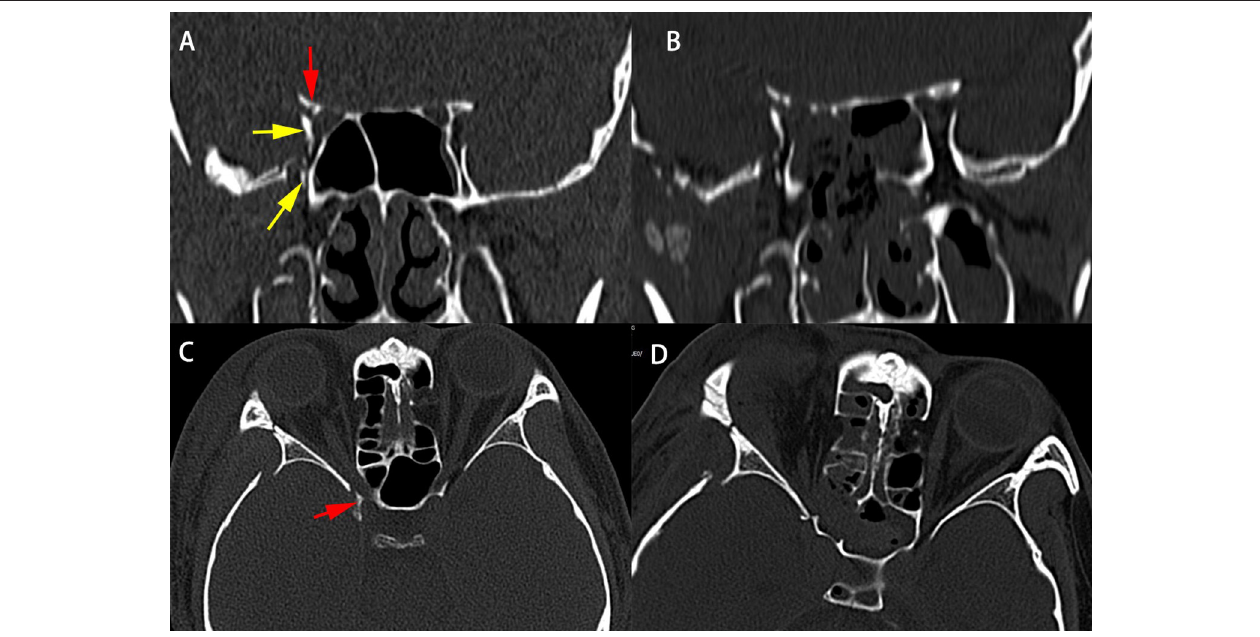
FIGURE 5 | CT scans of patient 1 before (A,C) and immediately after (B,D) surgery. Pre-operative coronal (A) and axial (C) CT scans showing compression of the superior orbital fissure by the medially displaced fracture segment of the greater wing of the right sphenoid (yellow arrowheads) and the optic canal (red arrowheads). Post-operative coronal (B) and axial (D) CT scans illustrate the decompression of the optic nerve, superior orbital fissure, and proper orbital apex.